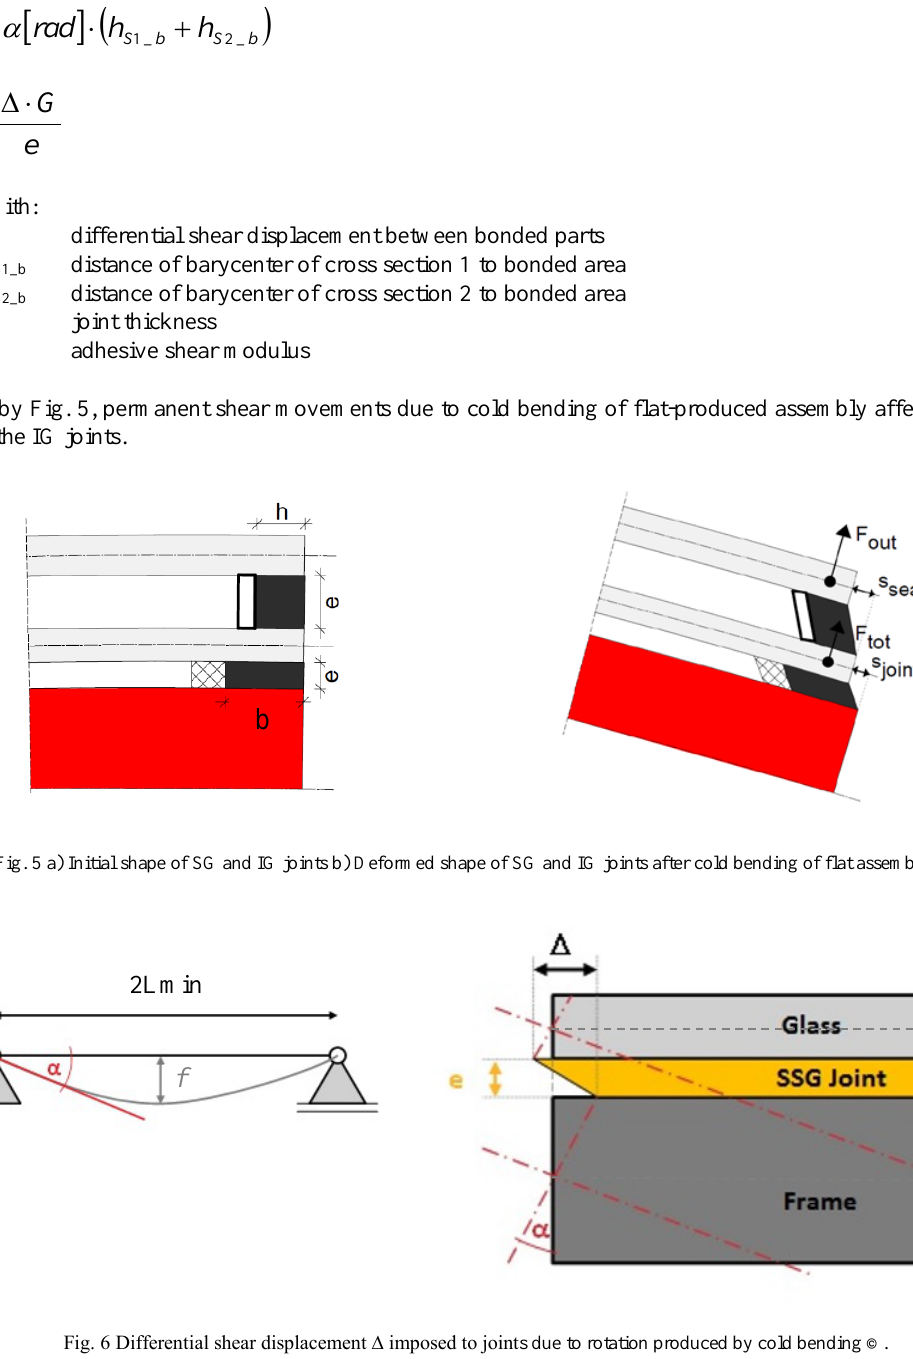
Fig. 6 Differential shear displacement ∆ imposed to joint s due to rotation produced by cold bending